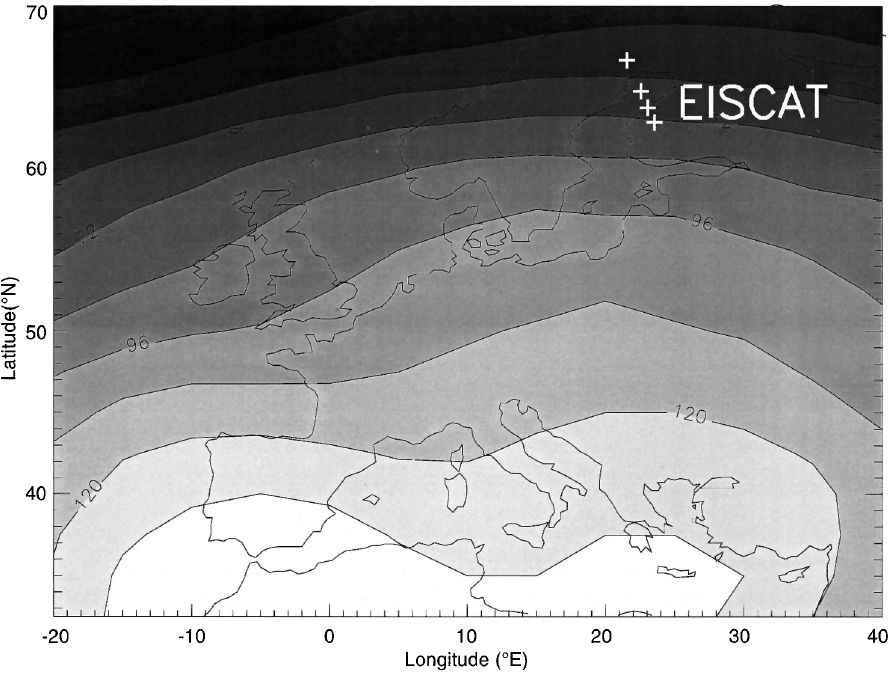
Fig. 5. TEC map and corresponding EISCAT CP3 trace on 3 February 1100 UT. The TEC contour lines are denoted in 1 (cid:93) 10 (cid:49)(cid:53) m (cid:126)(cid:50) and differ by 12 (cid:93) 10 (cid:49)(cid:53) m (cid:126)(cid:50)